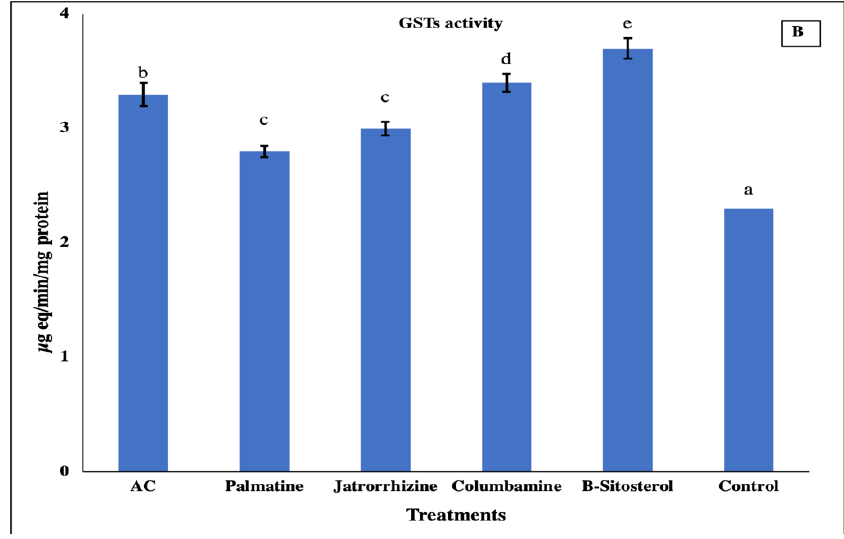
Figure 4. Effect of tested LC 50 concentrations of palmatine, jatrorrhizine, columbamine, β - sitosterol, and Annickia chlorantha extract (AC) on the enzymatic activities of acetylcholinesterase (AChE) ( A ) and glutathione S-transferase (GSTs) ( B ) in the third larval instar of the mosquito, Culex pipiens. Bars with different letters are significantly ( p < 0.05) different. Data presented as mean ± SE of three replicates.